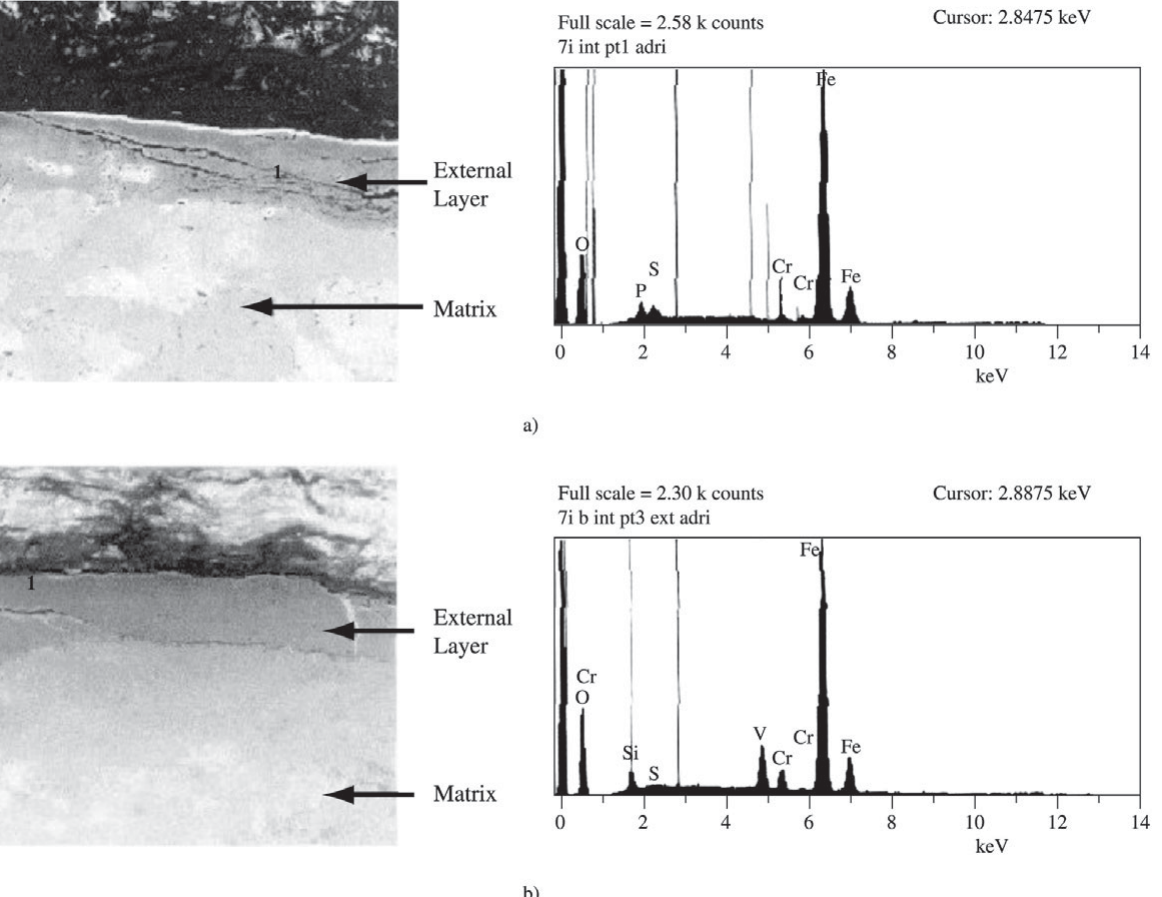
Figure 3. a) Image of internal layer by SEM and respective spectrum from EDS of point 1 indicated in the figure; b) Image of external layer by SEM and respective spectre from EDS of point 1 indicated in the figure.